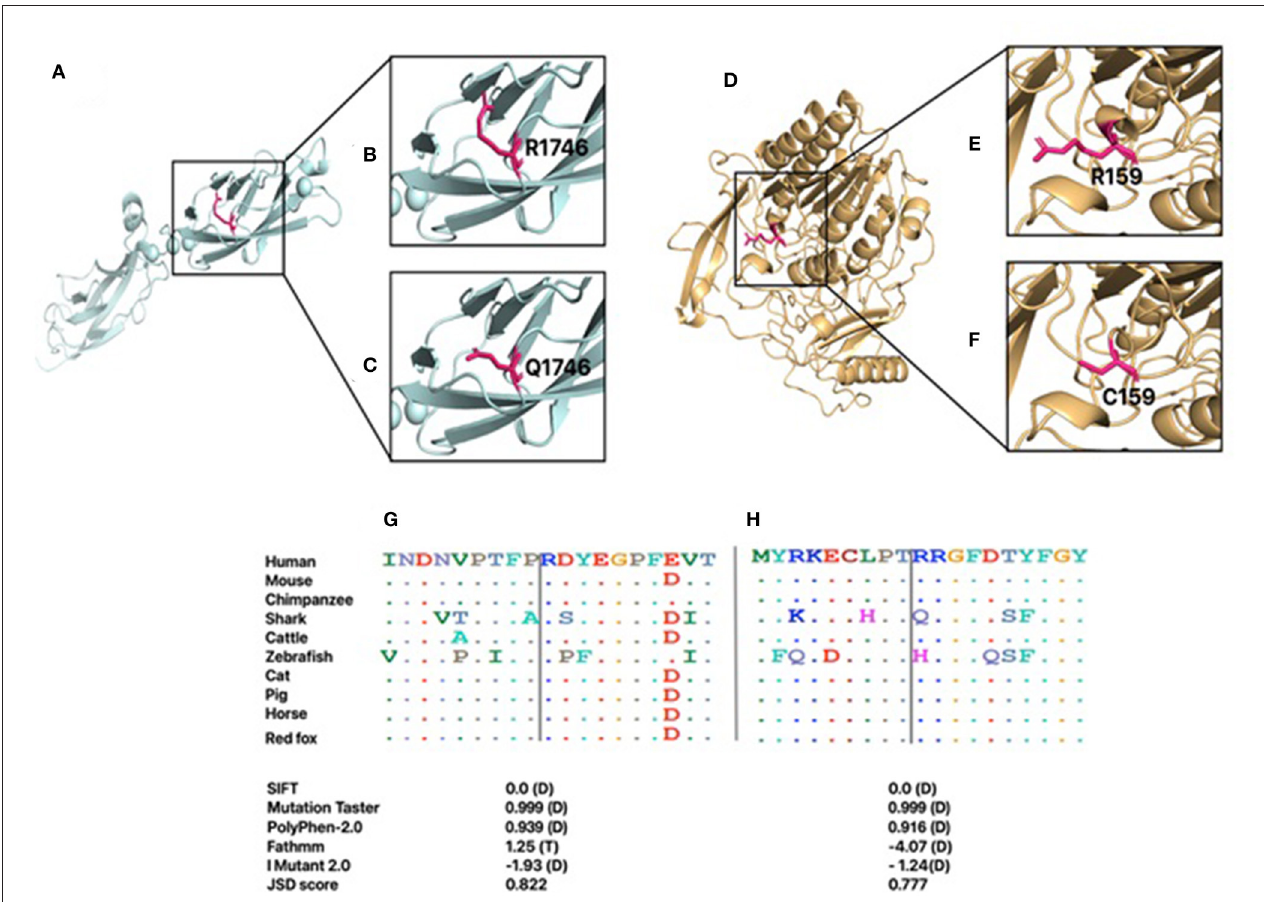
FIGURE 2 | The generated homology models for CDH23 and ARSB. The proteins are shown in cartoon representation, and the amino acid is demonstrated with a stick representation. The boxed region in A and D is enlarged in subsequent images. (A) Modeled structure of CDH23. (B) Wild-type R1746. (C) Mutant Q1746. (D) Modeled structure of ARSB. (E) Wild-type R159. (F) Mutant C159. Conservation of each amino acid is shown across species for both CDH23 (G) and ARSB (H). Predicted effects of the variants on protein structure and function based on SIFT, Fathmm, Mutation Taster, PolyPhen2.0, and I Mutant2.0 programs. D, damaging; T,